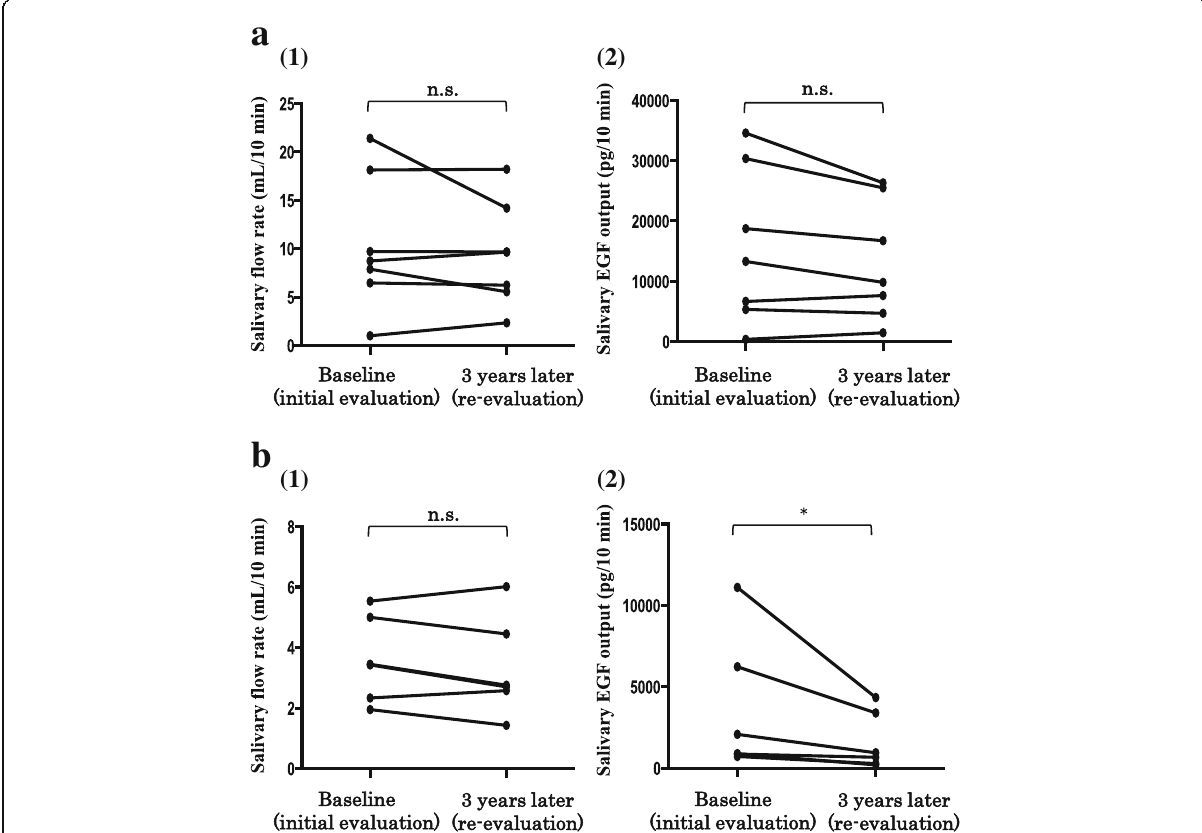
Fig. 3 Changes in the salivary flow rate and salivary epidermal growth factor (EGF) output according to the disease duration. a Short-duration Sjögren ’ s syndrome (SS) group. b Long-duration SS group. (1) Changes in the salivary flow rate. (2) Changes in the salivary EGF output. Statistical analysis was performed using the Wilcoxon signed-rank test. * p < 0.05; n.s., not